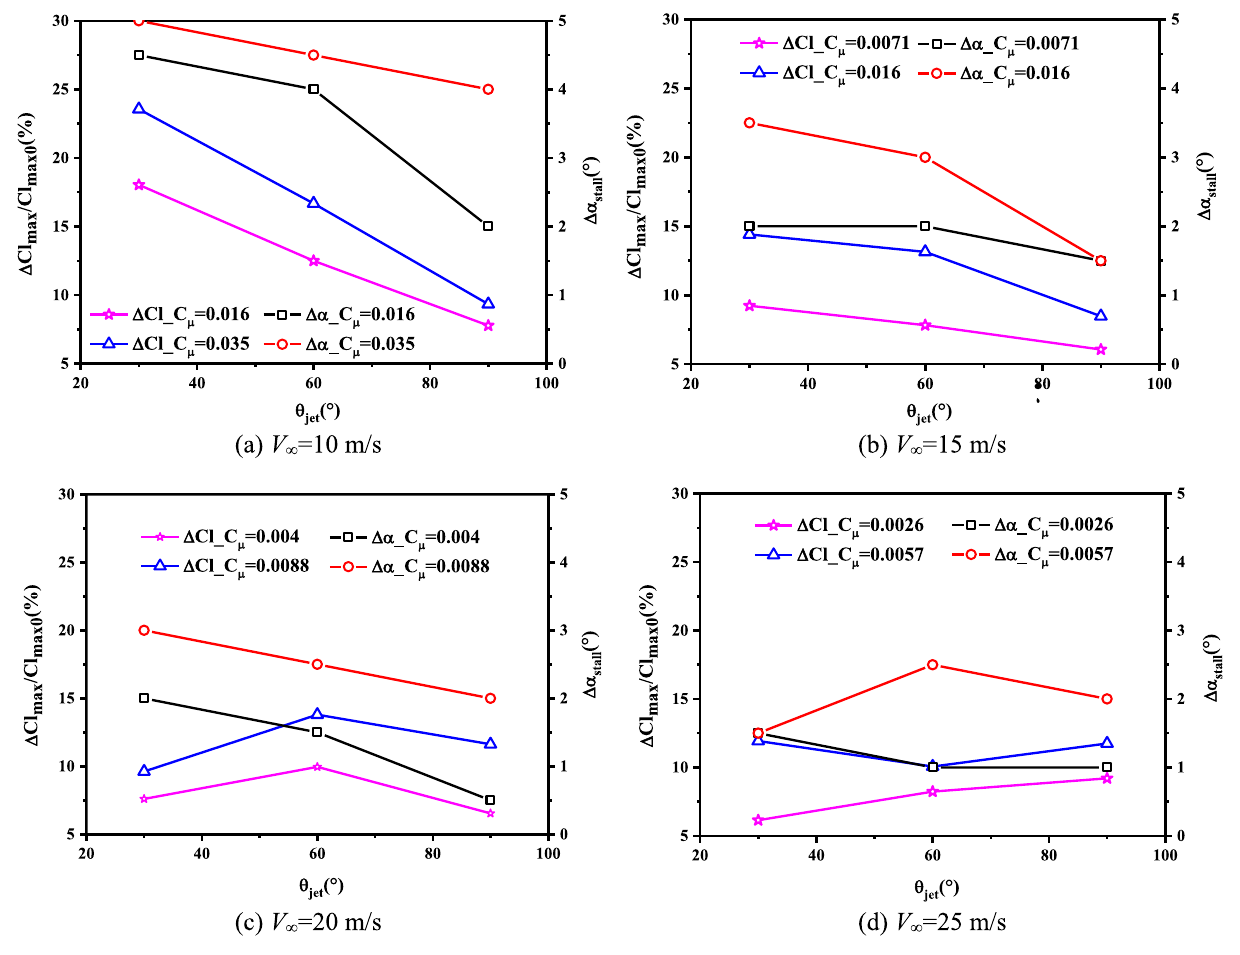
Figure 14. Effects of jet angles and momentum coefficients to the stall characteristics of